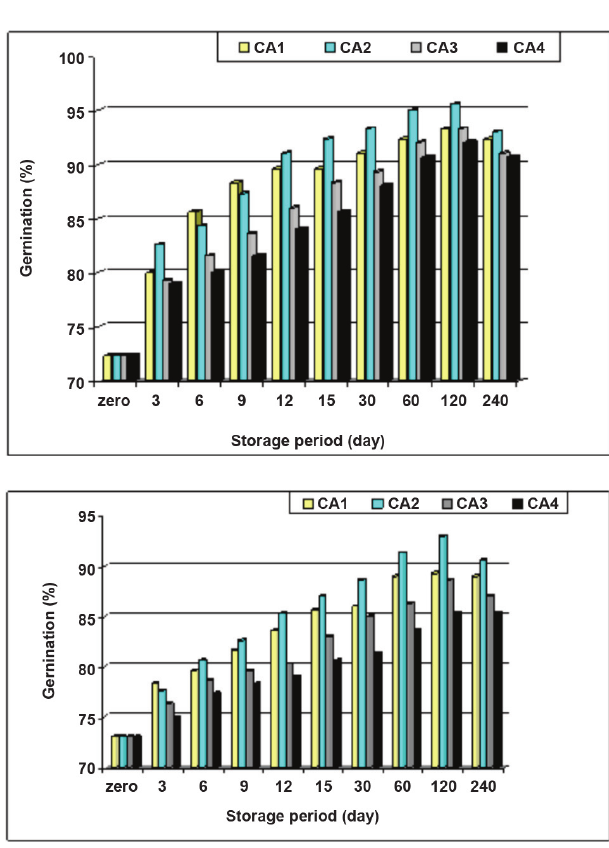
Fig. 2: Effect of the interaction between storage temperature (A, room temperature and B, 5 ° C or cold temperature), controlled atmosphere and exposure period on germination percent of onion seeds stored for 12 months. For more details about CA1 to CA4: CA1: 4 % CO 95.5 % N and 0.5 % O 2, 2 2 CA2: 8 % CO 91 % N and 1 % O 2, 2 2 CA3: 16 % CO 82 % N and 2 % O 2, 2 2 CA4: 24 % CO 73 % N and 3 % O 2, 2 91% N and 1% O ) on 2, 2 2